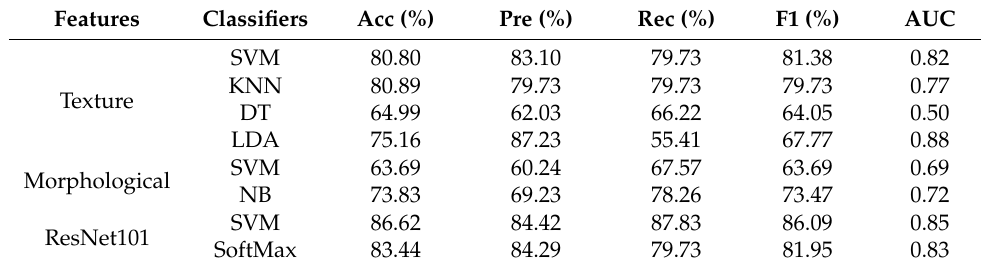
Table 3. The classification results with a single feature combined with different classifiers.